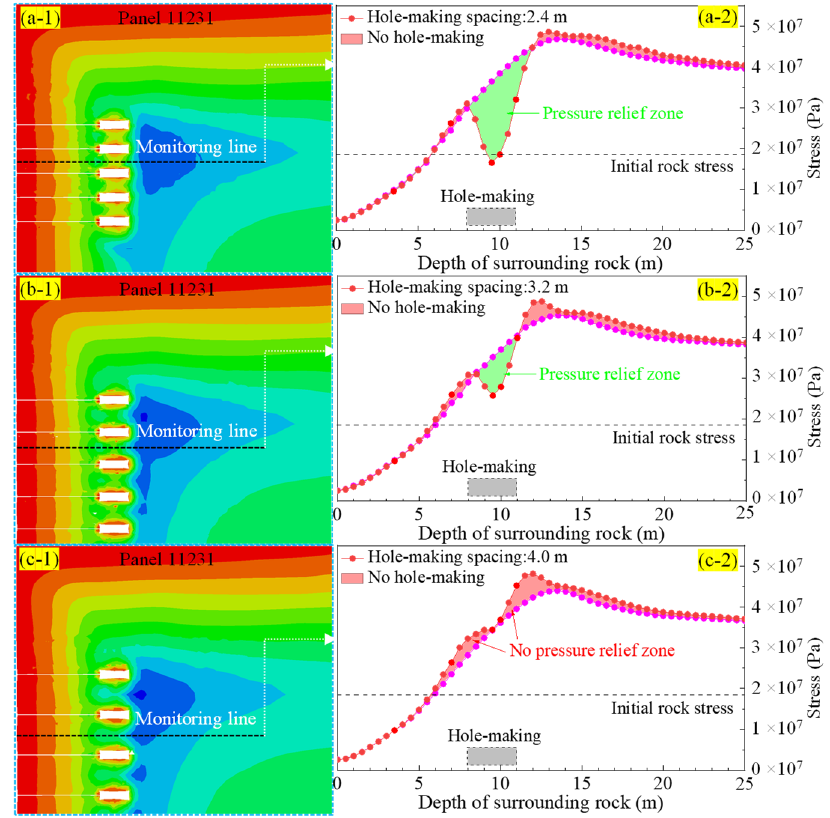
Figure 17. Stress distribution on roadway rib at different values of hole-making spacing in the mining influence stage. ( a-1 ) Stress nephogram with spacing of 2.4 m; ( b-1 ) Stress nephogram with spacing of 3.2 m; ( c-1 ) Stress nephogram with spacing of 4.0 m; ( a-2 ) Stress curve with spacing of 2.4 m; ( b-2 ) Stress curve with spacing of 3.2 m; ( c-2 ) Stress curve with spacing of 4.0 m.